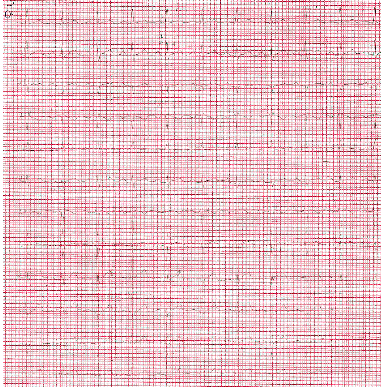
Figure 4. ECG upon discharge, shows sinus rhythm 90/min, with normal PR, QTc intervals and QRS complex.